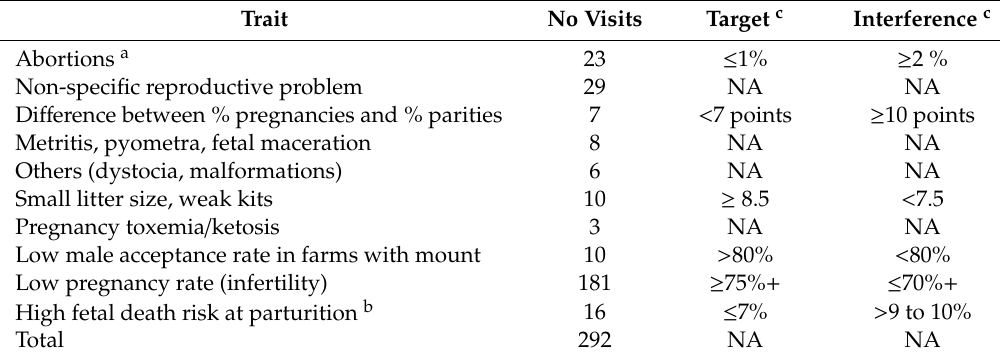
Table 3. Classification of reproductive problems diagnosed as the main reason for 292 visits (out of 11,382 visits in total) to 176 farms (out of 1373 farms) in Spain and Portugal from 1994 to 2019. Trait No Visits Target c Interference c Abortions a 23 ≤ 1% ≥ 2 % Non-specific reproductive problem 29 NA NA Di ff erence between % pregnancies and % parities 7 < 7 points ≥ 10 points Metritis, pyometra, fetal maceration 8 NA NA Others (dystocia, malformations) 6 NA NA Small litter size, weak kits 10 ≥ 8.5 < 7.5 Pregnancy toxemia / ketosis 3 NA NA Low male acceptance rate in farms with mount 10 > 80% < 80% Low pregnancy rate (infertility) 181 ≥ 75% + ≤ 70% + High fetal death risk at parturition b 16 ≤ 7% > 9 to 10% Total 292 NA NA a Percentage of abortions / services. b Coudert [38] suggested a target of 2% for parturitions with all fetuses stillborn. c Derived from Rosell [5]. NA—not